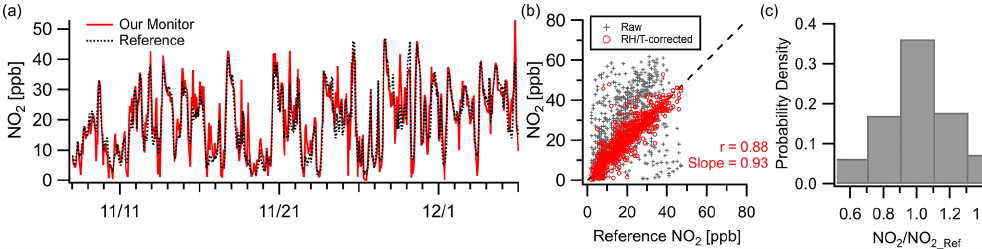
Figure 3. Outdoor ambient monitor comparison of NO 2 from Baltimore, MD (Oldtown site). (a) Time series of RH– T -corrected multipollu- tant monitor data with reference data. (b) With RH– T correction factors the data achieve good correlation. (c) Over 35% of the measurements are within 10% of the reference